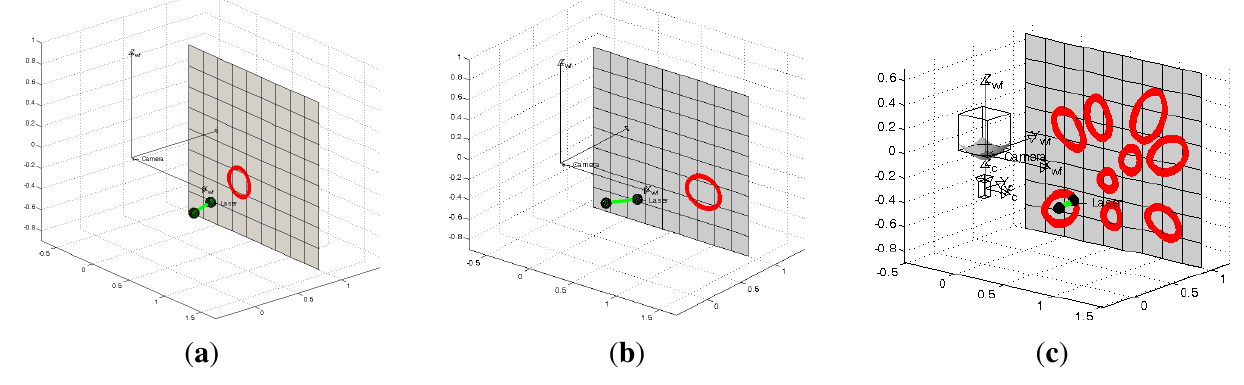
Figure 6. Different configurations of the proposed structured light system. ( a ) Single conic with azimuth 20 ◦ ; ( b ) Single conic with azimuth 30 ◦ ; ( c ) Multiple conics varying the azimuth.